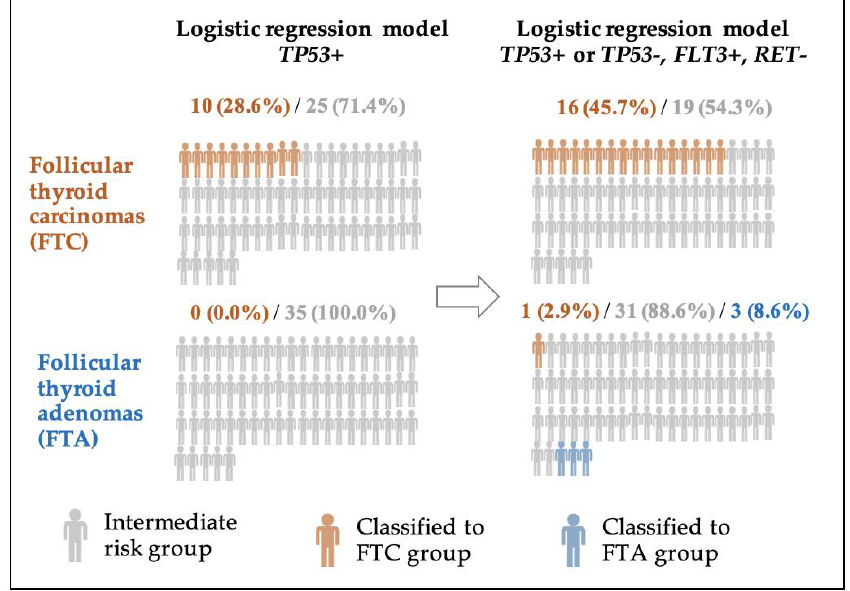
Figure 2. Reclassification of individuals predicted to follicular thyroid cancer (FTC) group and to follicular thyroid adenoma (FTA) group according to logistic regression model based on mutational status.